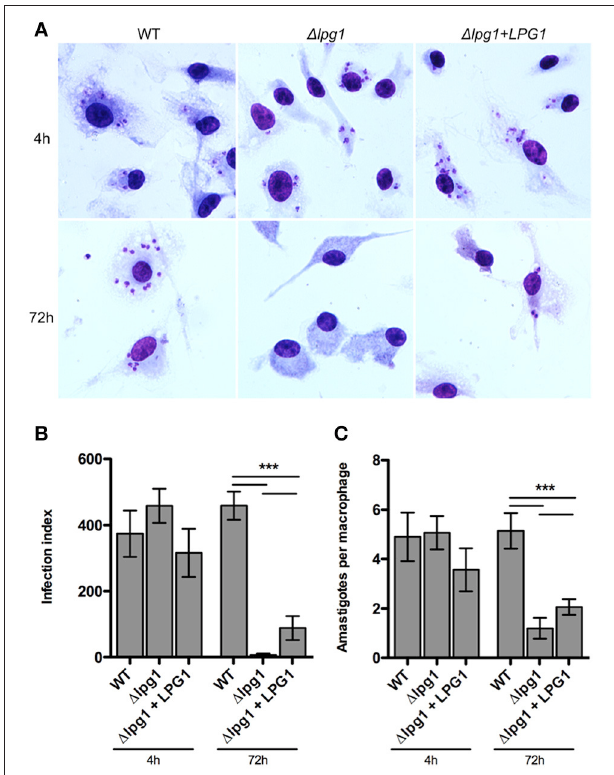
FIGURE 4 | LPG1 promotes intraphagosomal survival in infected macrophages. C57BL/6 BMDMs were infected with WT, 1 lpg1 and 1 lpg1 + LPG1 promastigotes as described under Materials and Methods. At 4 and 72h post-infection, cells were fixed and Giemsa-stained. (A) Micrographs of infected BMDMs at 4 and 72h post-infection. The infection index (B) and amastigotes per macrophage (C) were quantified by light microscopy. Arrows point to amastigotes inside a parasitophorous vacuole. Original magnification × 1000. Statistical differences were evaluated using the Student Newman-Keuls test. *** p < 0.001 compared to WT or between